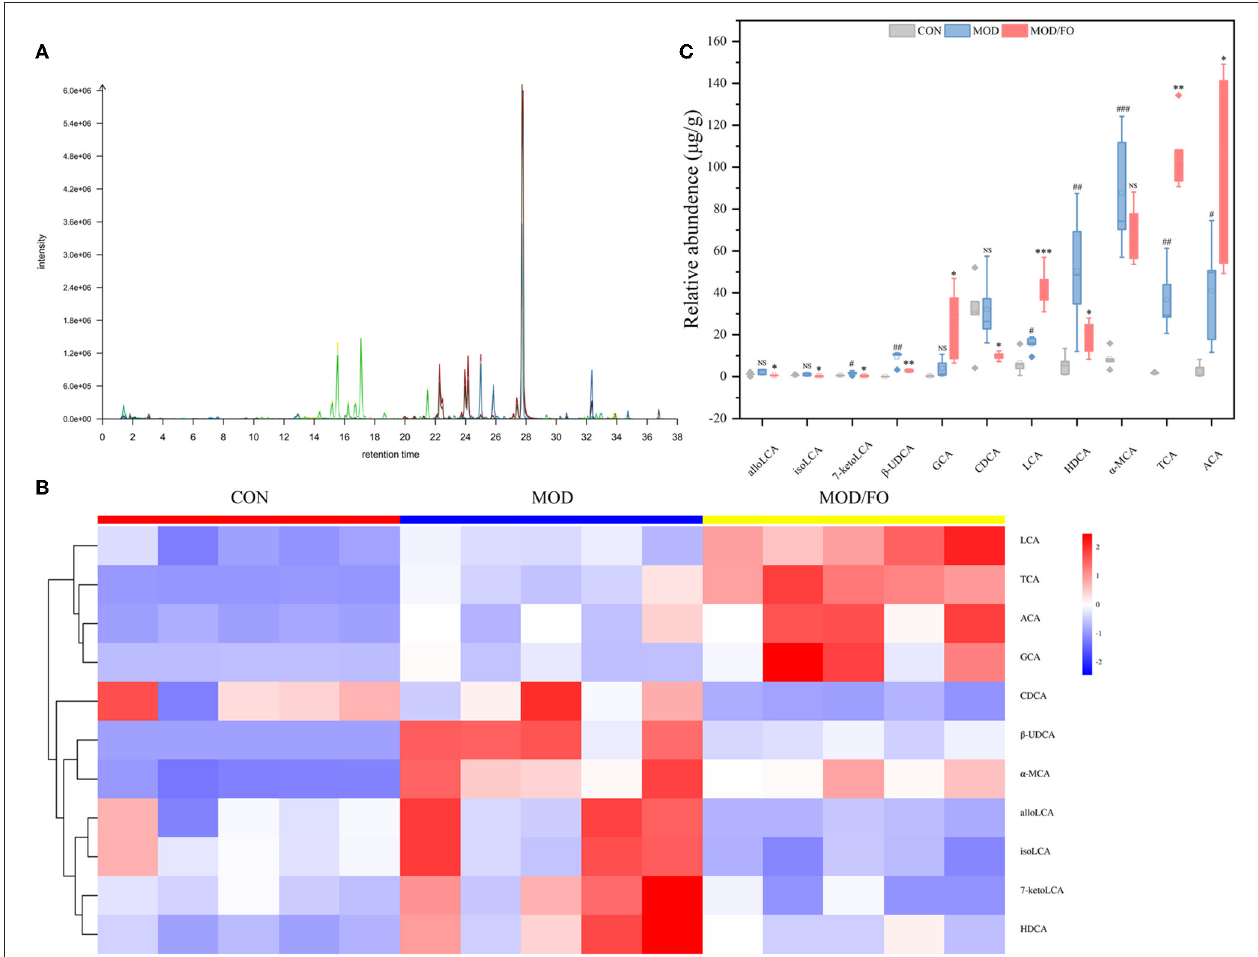
FIGURE 5 | Levels of BAs in fecal intestinal metabolites. (A) Chromatogram of mice stool. (B) Heat map clustering. (C) Determination of levels ( µ g/g) of allolithocholic acid (alloLCA), isolithocholic acid (isoLCA), 7-ketodeoxycholic acid (7-ketoLCA), β -ursodeoxycholic acid ( β -UDCA), chenodeoxycholic acid (CDCA), and hyodeoxycholic acid (HDCA), lithocholic acid (LCA), allocholic acid (ACA), glycocholic acid (GCA), and taurocholic acid (TCA) by Liquid chromatography-mass spectrometer (LC-MS). Data were presented as mean ± SEM. # P < 0.05, ## P < 0.01, ### P < 0.001, CON group vs. MOD group. * P < 0.05, ** P < 0.01, *** P < 0.001, MOD group vs. MOD/FO group. NS, no